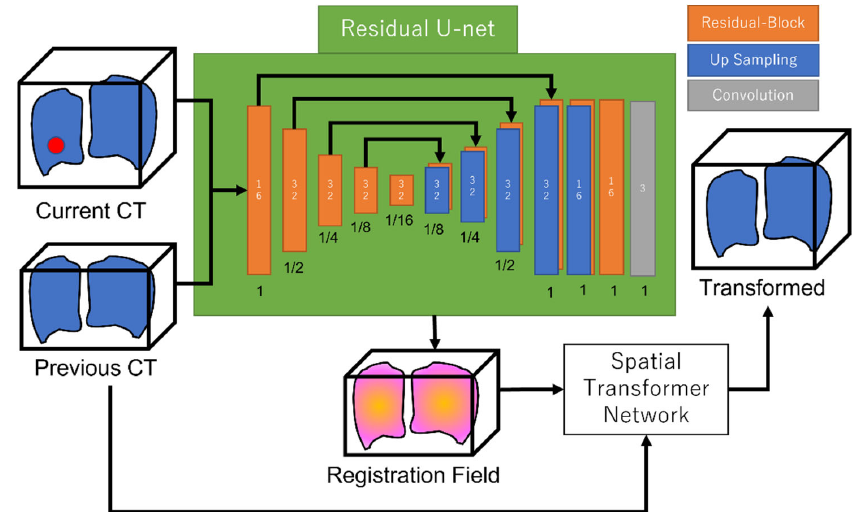
Figure 4. ResidualVoxelMorph network architecture.